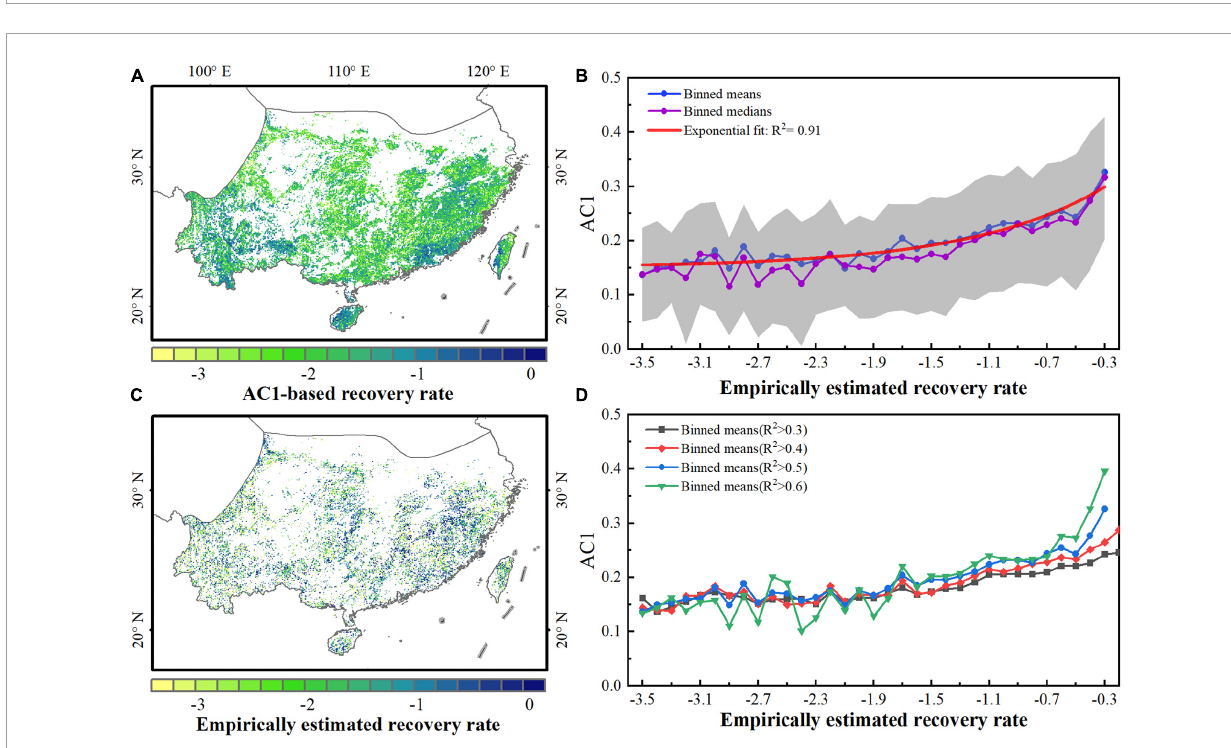
FIGURE3 Comparison between theoretical resilience (AC1) metrics and empirical recovery rates based on satellite kNDVI data. (A) Theoretical estimate of the recovery rate computed from the AC1 at each grid. (B) Empirical estimate of the recovery rate (for well-determined exponential fits, R 2 > 0.2). (C) Relationship between AC1 and empirical recovery rates from exponential fits with R 2 > 0.5. (D) Binned means of AC1 as a function of the empirically estimated recovery rate under different R 2